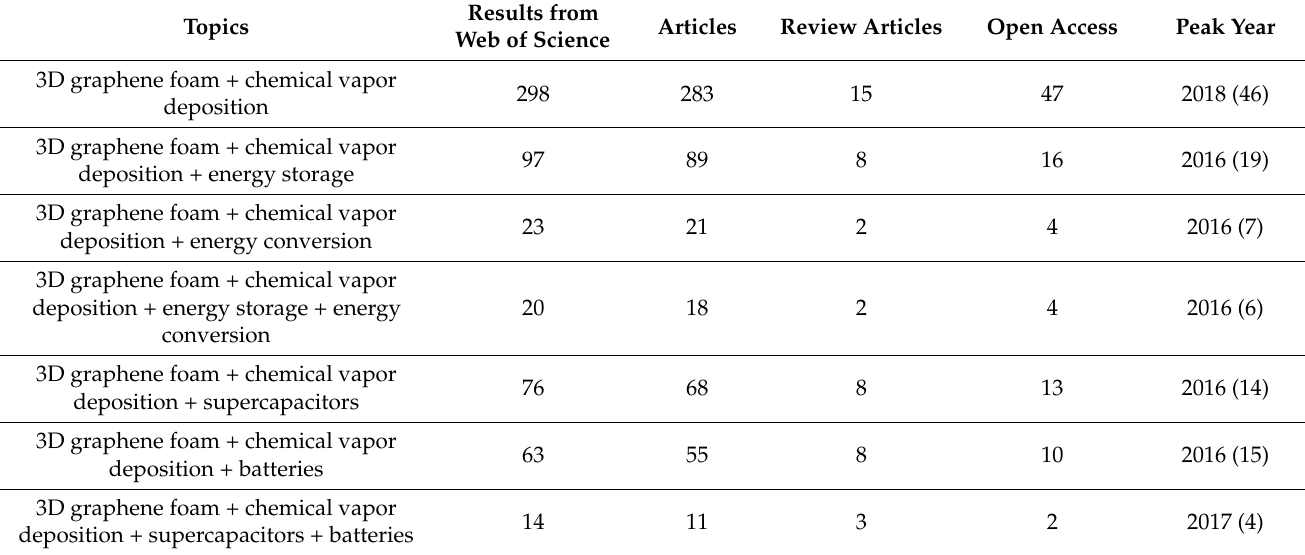
Table 1. The statistical data of published articles on the indicated topics over the 2011 − 2022 time